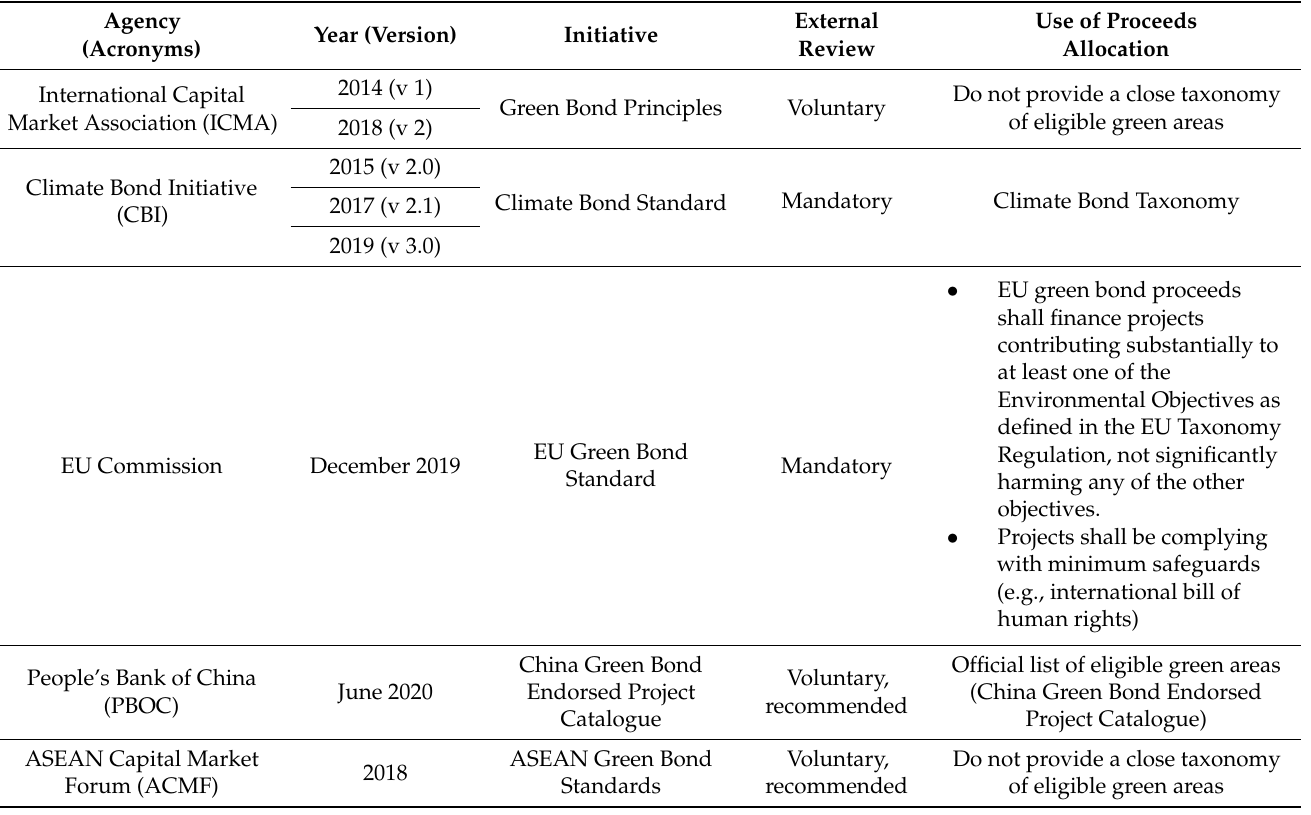
Table 2. Main green bond standard initiative worldwide.